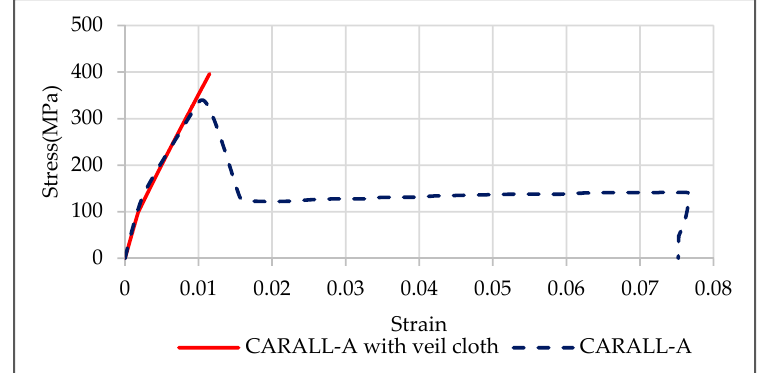
Figure 25. Tensile behavior of CARALL FMLs having polyester veil cloth layers.